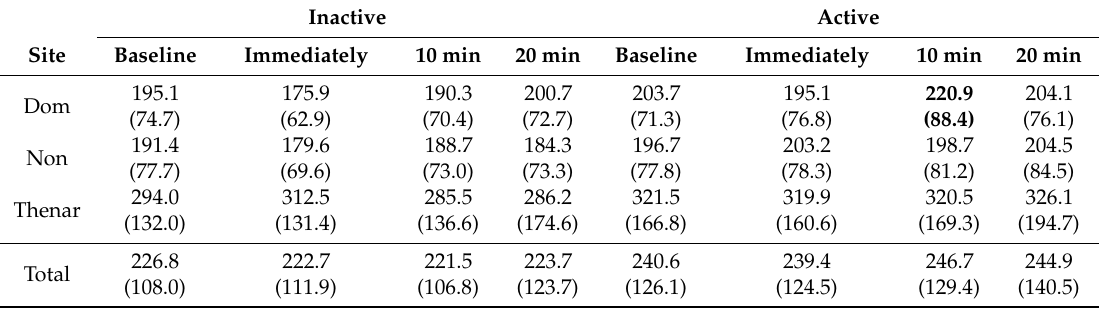
Table 1. Presentation of means (SD) of pressure pain thresholds (PPT in kPa) of the three test sites at di ff erent time points. The values in bold indicates a significant di ff erence from placebo. Dom = Dominant hand side masseter muscle, Non = Non-dominant hand side masseter